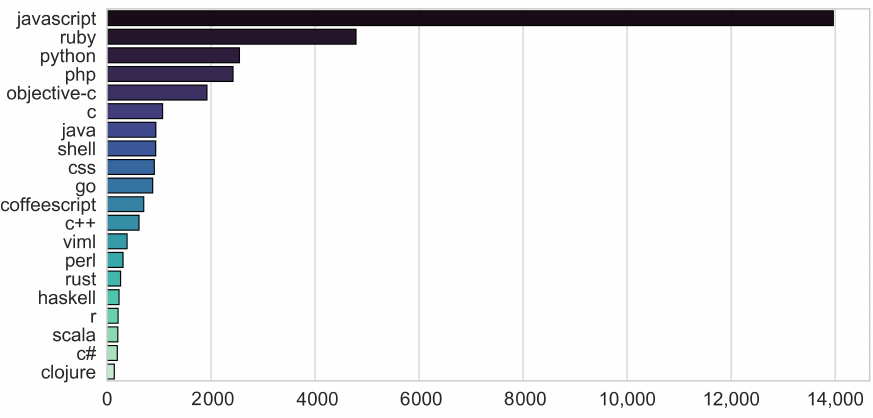
Figure 5. The most common used languages in the dataset.